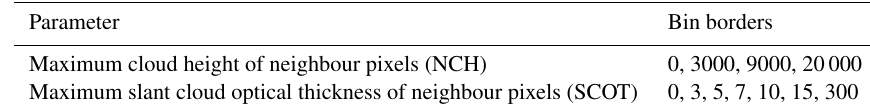
Figure 9. The difference between the centre pixel NO 2 TVCD and the average of the NO 2 TVCD in the cloud-free neighbours as a function of cloud height maximum of neighbour pixels. The median of the difference is given in the legend together with the maximum of a Gaussian kernel-density probability density function estimate of the data points. The size of the data points illustrates the maximum cloud optical thickness in neighbour pixels (NCOTM). It varies between the minimum and maximum NCOTM values given in the legend. Table 1. Binning of parameters used to quantify the cloud shadow